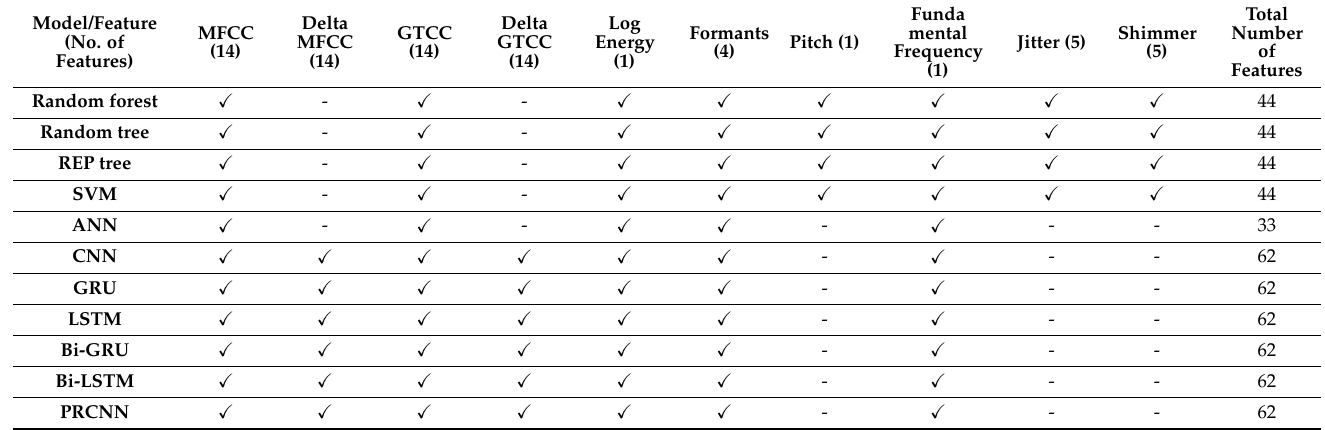
Table 1. List and number of speech features used for ML and DL